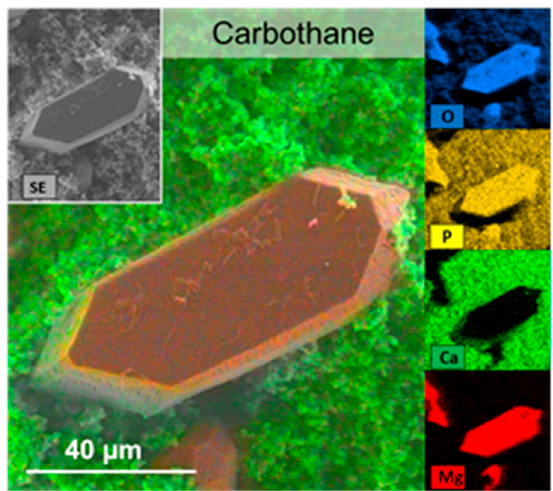
Figure 6. EDX analyses of encrustations on Carbothane. Mapping of the elements shows large crystals of Mg, P, and O, presumably being struvite (appearing orange). The Ca- and P-containing matrix of calcium carbonate apatite (appearing green) was multi-layered and rough in nature. FE-SEM Merlin VP compact (Zeiss) with EDX-detector XFlash 6/30 (Bruker).